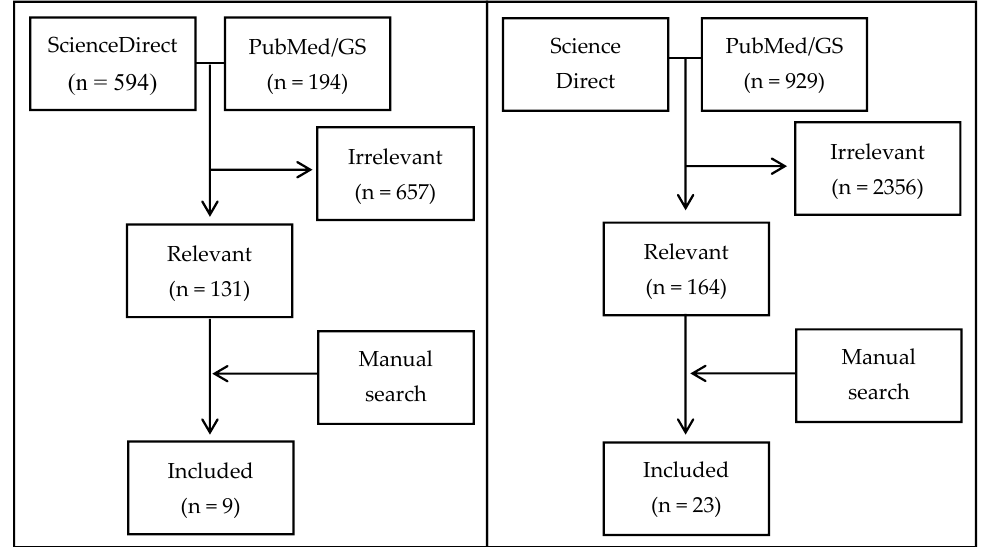
Figure 1. Identification and inclusion of relevant articles; GS = Google Scholar.